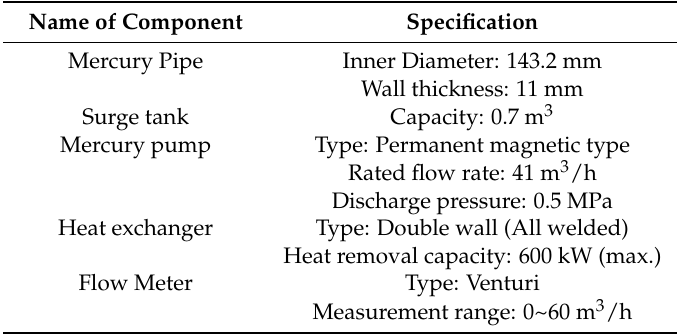
Table 1. Primary specifications of mercury circulation system